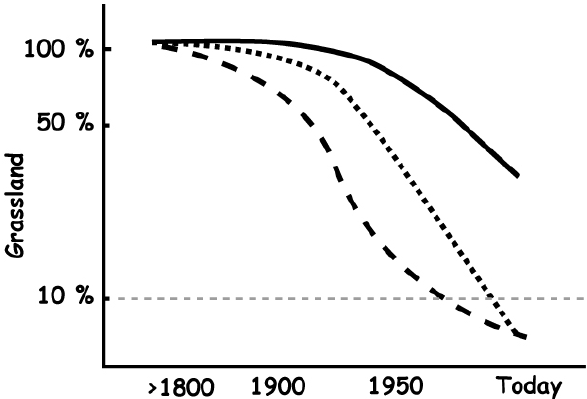
Figure 5. Illustration of trajectories representing grassland decline, in relation to a threshold (10% of remaining grassland area), below which extinction debt has not been detected. Thus, below this threshold the extinction debt is “paid”. The two broken lines represent different trajectories for strongly transformed landscapes, and the solid line represents landscapes with a considerable amount of semi-natural grasslands left. The figure is a generalization of data presented in